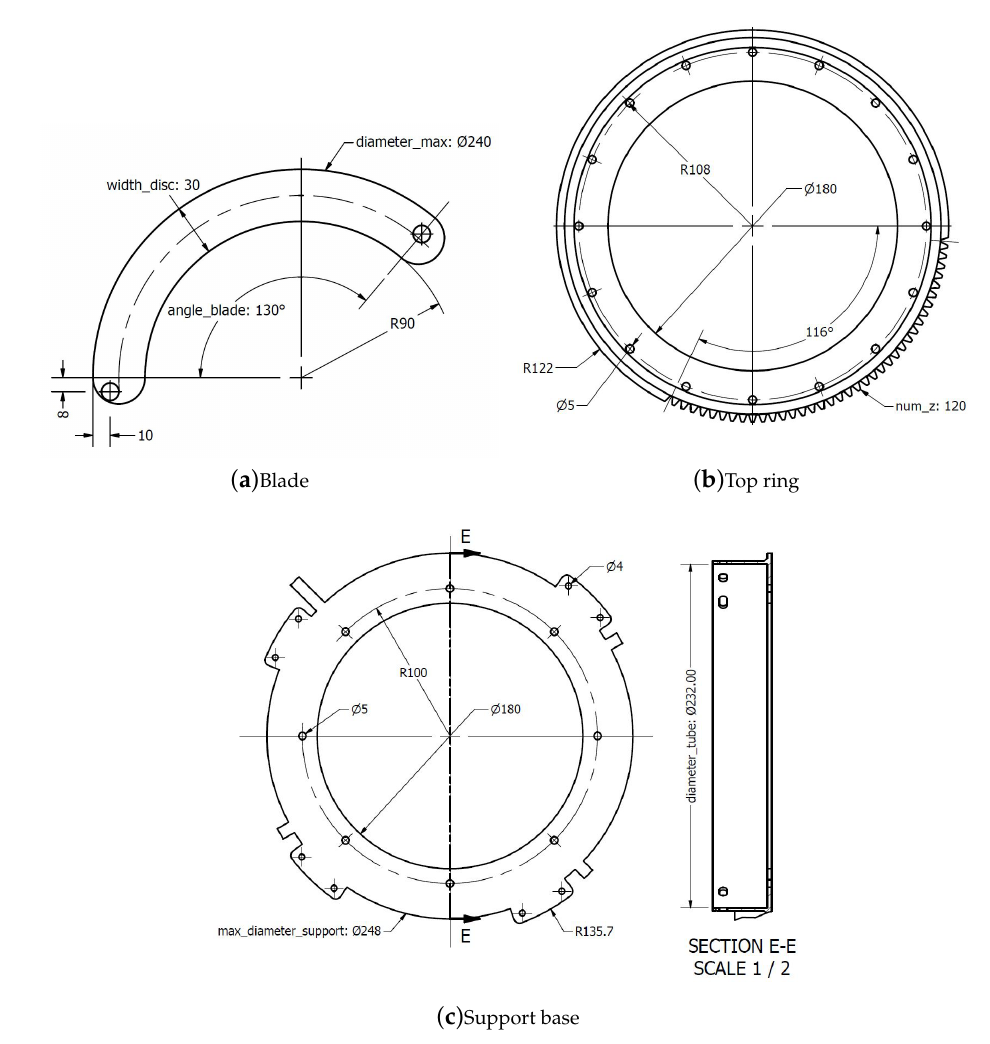
Figure 11. Sectional views of the cover. All dimensions in